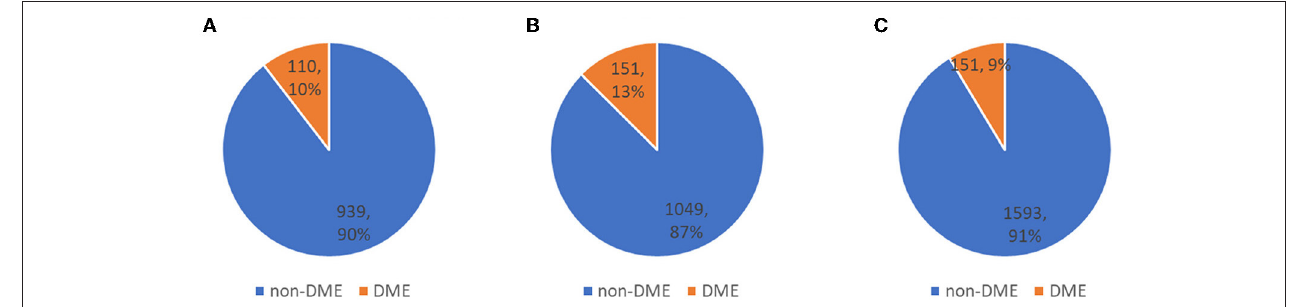
TABLE 4 | Performance of dual and fusion model for the three datasets.